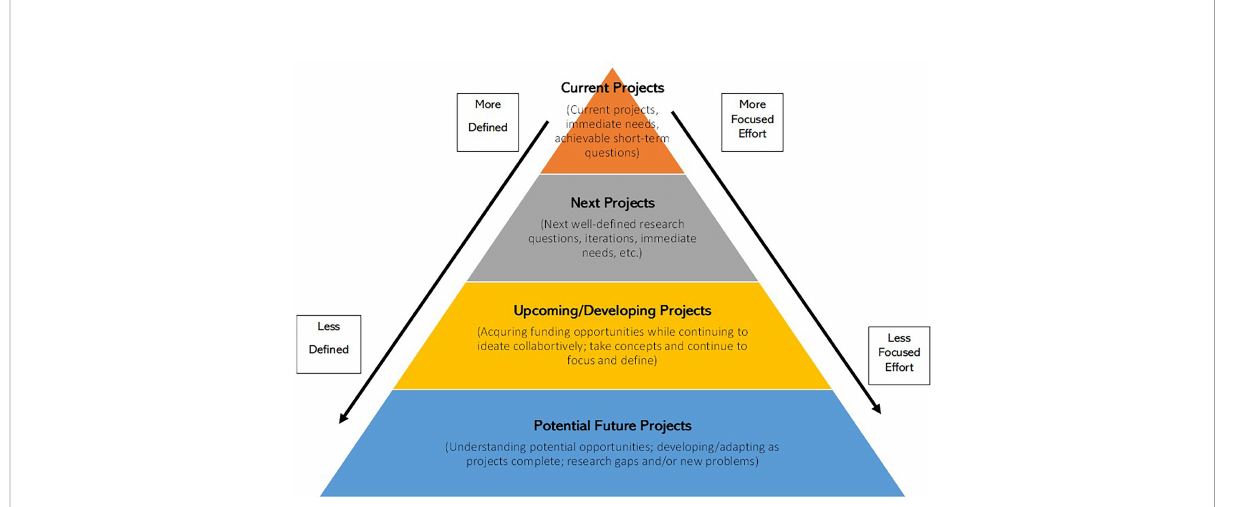
FIGURE 1 Research goals or questions are set by the co-production group according to this diagram, where well de fi ned, short-term questions are addressed more immediately, but at the same time we develop new project ideas to address in the medium-term, and developing projects based on participant input that may fall outside of current funding or time limitations. Credit: Jared